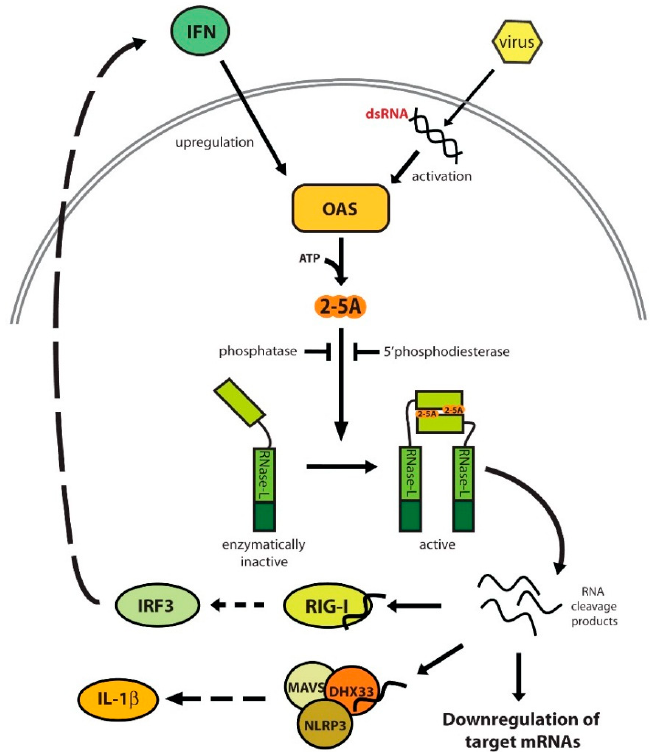
Figure 1. The 2 ′ -5 ′ -linked oligoadenylate (2-5A) System. IFN treatment induces the transcription of oligoadenylate synthetase (OAS), and virus infection produces dsRNA that activates OAS to synthesize 2-5A. Latent RNase-L binds 2-5A and oligomerizes into an active complex capable of cleaving ssRNA into retinoic acid-inducible gene-I (RIG-I) and nucleotide-binding oligomerization domain-like receptor 3 (NLRP3) inflammasome-activating small RNAs. Cleavage of target RNAs can regulate cellular and viral gene expression. RNase-L activation can be attenuated by phosphatase and 2 ′ -phosphodiesterase mediated degradation of 2-5A. Solid arrows denote direct interactions and dashed arrows signify that intermediary steps occur.